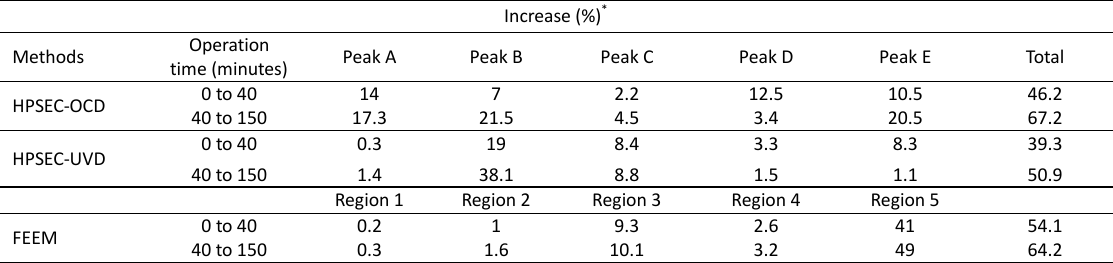
Table 1: Variation of five organic fractions expressed by HPSEC-OCD, HPSEC-UVD and FEEM from bionet filter operation with nitrification processes Increase (%) * Methods